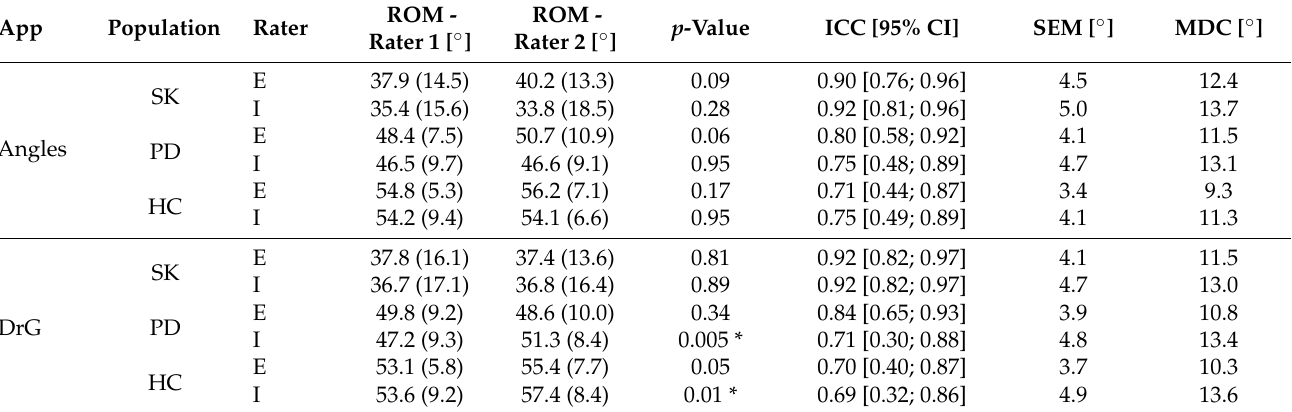
Table 3. Inter-rater reliability of ROM measures from the Angles and DrGoniometer